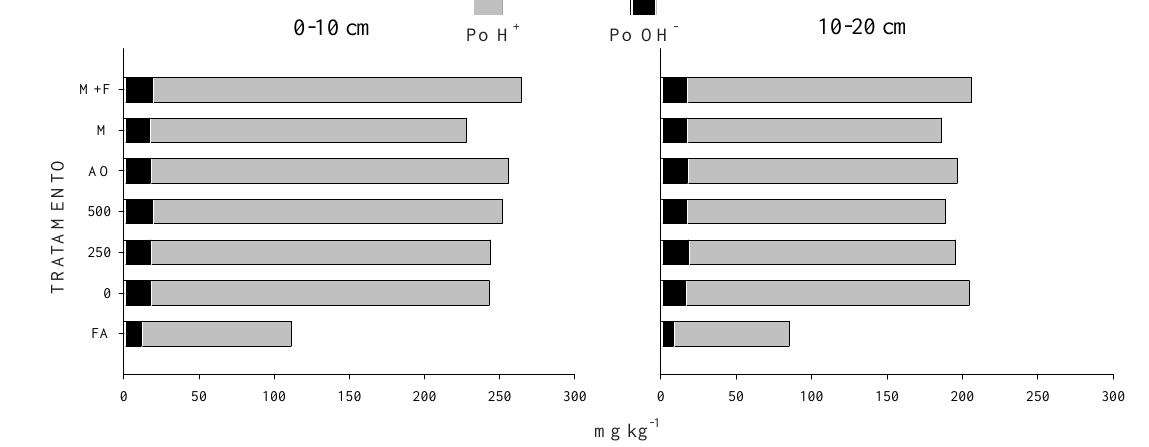
Figura 2. Médias dos valores das frações de Po solúvel em meio básico (Po (OH - )) e solúvel em meio ácido (Po (H + )), nas profundidades de 0–10 e 10– 20 cm. FA: Floresta Atlântica; 0: ausência de adubo orgânico e mineral; 250 e 500: 250 e 500 kg ha -1 de 4–14–8, respectivamente; AO: 40 m³ ha -1 adubo orgânico; M: milho; M + F: milho + feijão